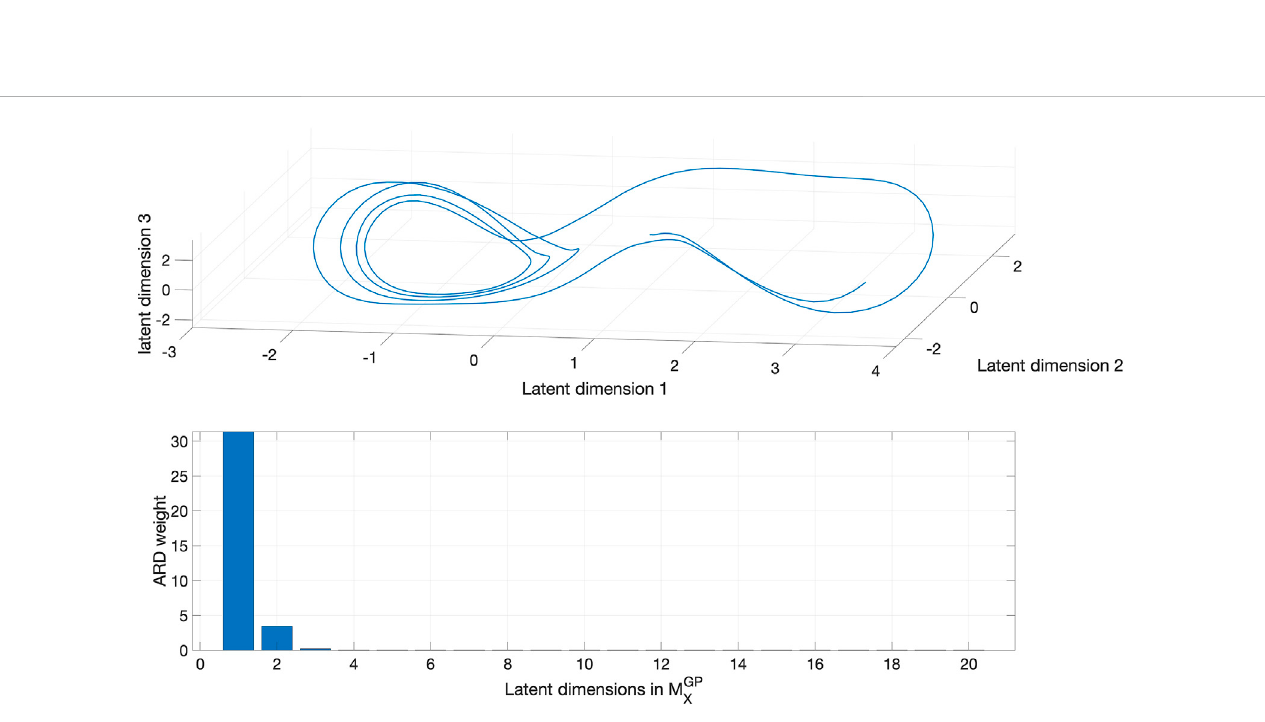
FIGURE 3 The reconstructed Lorenz attractor from X ( t ) using GP-based approach (top) and ARD weights of learned latent dimensions (bottom). The number of dimensions with non-zero ARD weights is three, which is the true dimension of the Lorenz attractor. The GP-based approach is capable of learning the dimension of the latent attractor from data in an automated